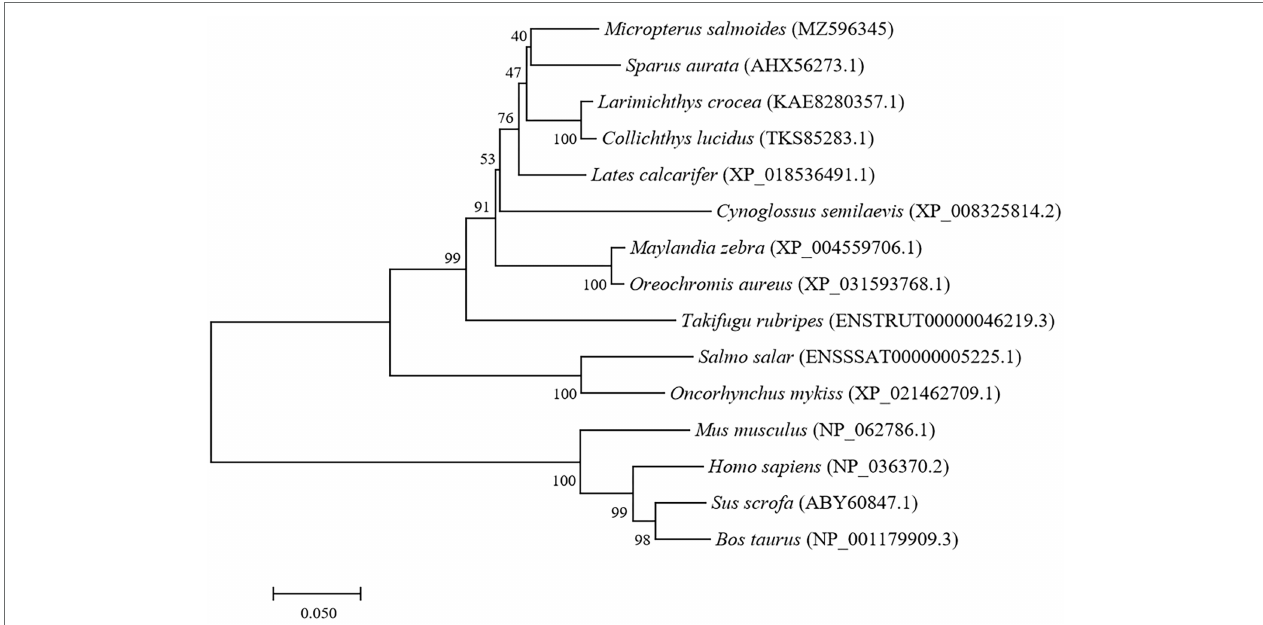
FIGURE 2 | Phylogenetic tree of largemouth bass SIRT1 (GenBank No. MZ596345) with other vertebrate counterparts. The horizontal branch length is proportional amino acid substitution rate per site. The numbers represent the frequencies with which the tree topology presented here was replicated after 1,000 bootstrap